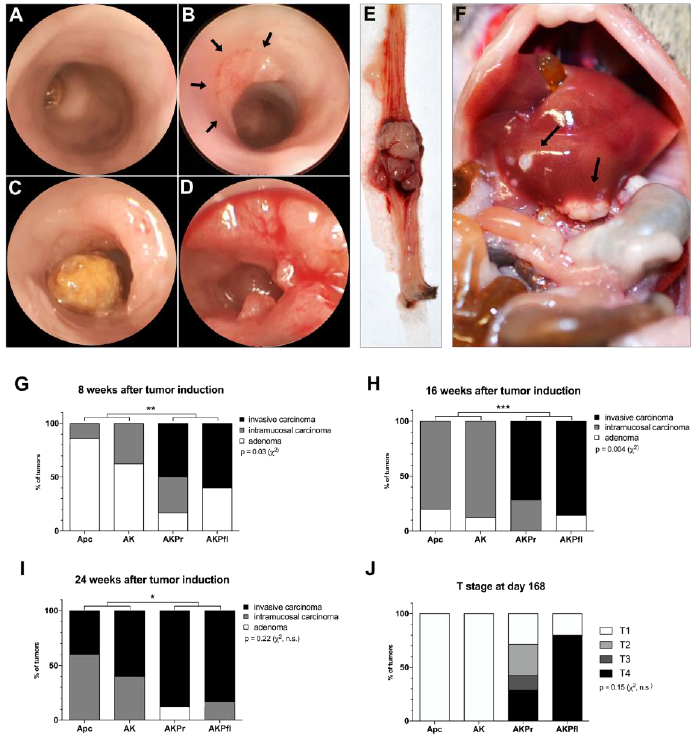
Figure 1. Trp53 conditional mutations lead to fast tumor progression and metastatic behavior in murine CRC. ( A – D ) After tumor induction via adeno-cre viral infection, mice were submitted to colonoscopy. Representative images were collected for ( A ) normal colon prior to adeno-cre infection, ( B ) early adenoma (arrows) in an Apc mouse, ( C ) preinvasive intramucosal carcinoma in an AK mouse, and ( D ) advanced adenocarcinoma in an AKPr mouse (note contact vulnerability). All above diagnoses were made histologically after colonoscopy. ( E ) Distal colon with a large tumor in an AKPfl mouse. ( F ) Liver metastases (arrows) in an AKPr mouse. ( G – I) Quantification of tumor invasiveness at 8 weeks, 16 weeks, and 24 weeks after tumor induction. (J) Local T staging of all invasive tumors after 24 weeks of tumor growth. * p < 0.05; ** p < 0.01; *** p < 0.001. Apc, Apc fl/fl mice; AK, Apc fl/fl /Kras LSL-G12D/+ mice; AKPr, Apc fl/fl /Kras LSL-G12D/+ /Trp53 LSL-R172H/+ mice; AKPfl, Apc fl/fl /Kras LSL-G12D/+ /Trp53 fl /fl